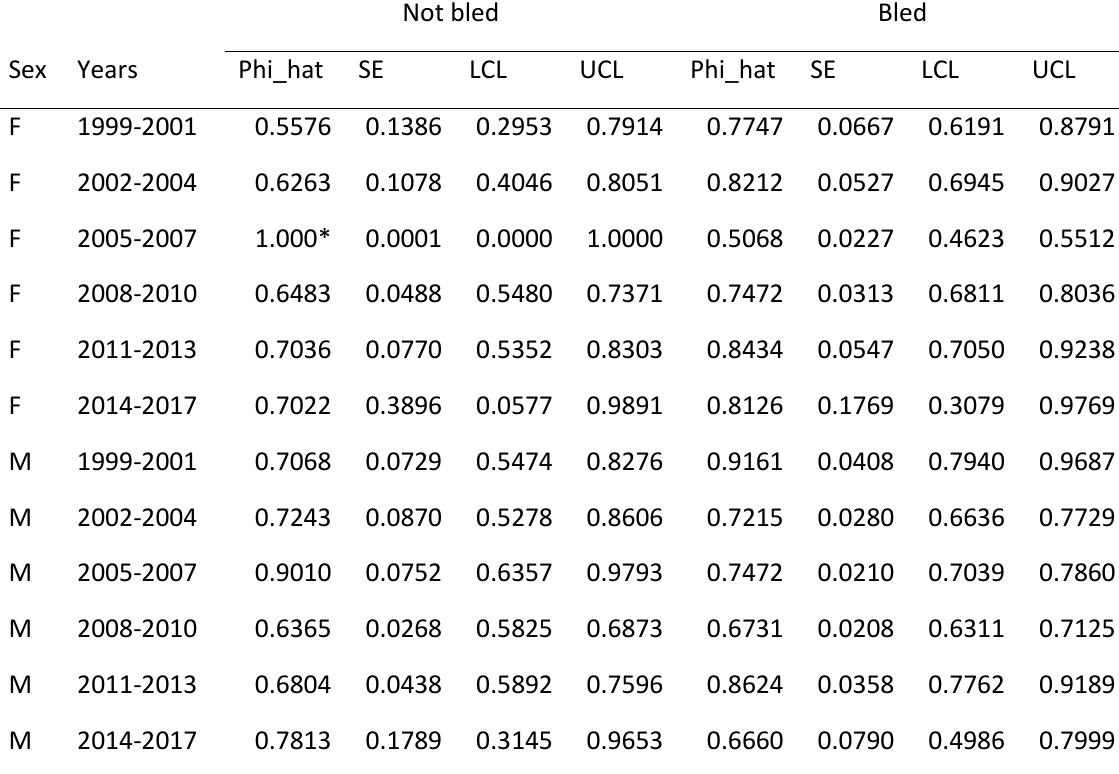
Table 22. Apparent survival (Phi_hat) estimated from the best fitting model (Table 21). Estimates are annual survival within 3-year periods with standard error (SE) and 95% confidence intervals (LCL,